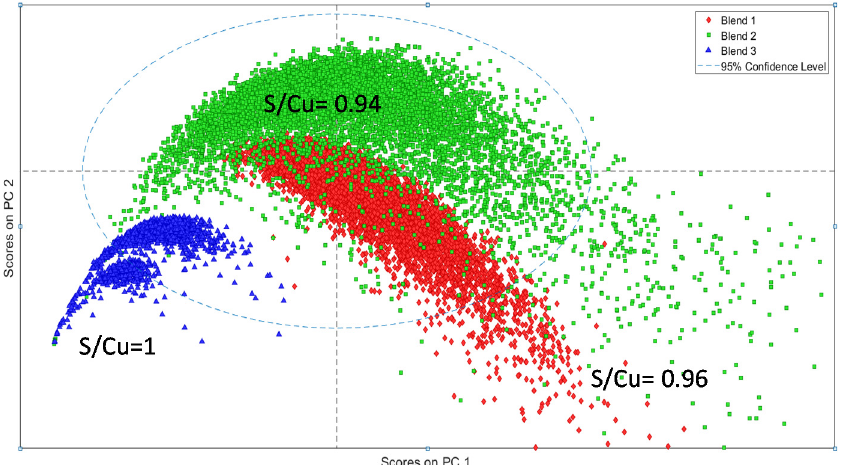
Figure 8. PC1–PC2 scores from principal component analysis (PCA) applied to the identification of different types of concentrates [27]. Blend 1: Cu = 28.0%, Fe = 26.2% and, S = 27.1 with S/Cu = 0.96. Blend 2: Cu = 28.3%, Fe = 25.5% and, S = 26.6 with S/Cu = 0.94. Blend 3: Cu = 26.7%, Fe = 25.3% and, S = 26.6 with S/Cu = 1.00. The composition is given in weight percent.